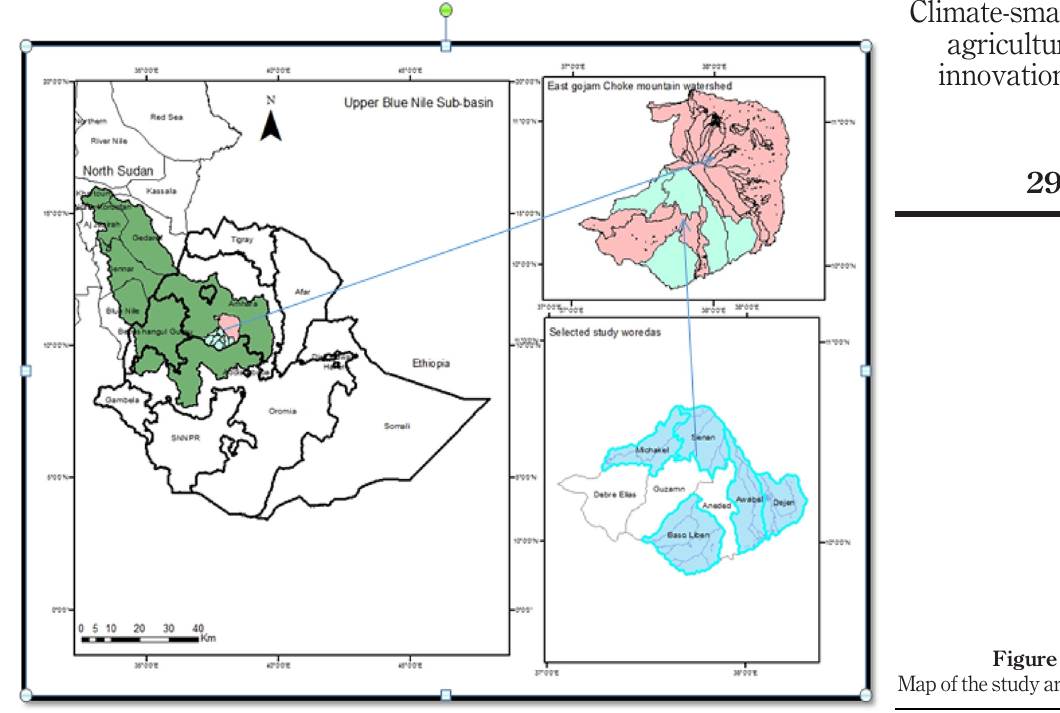
Figure 1. Map of the study